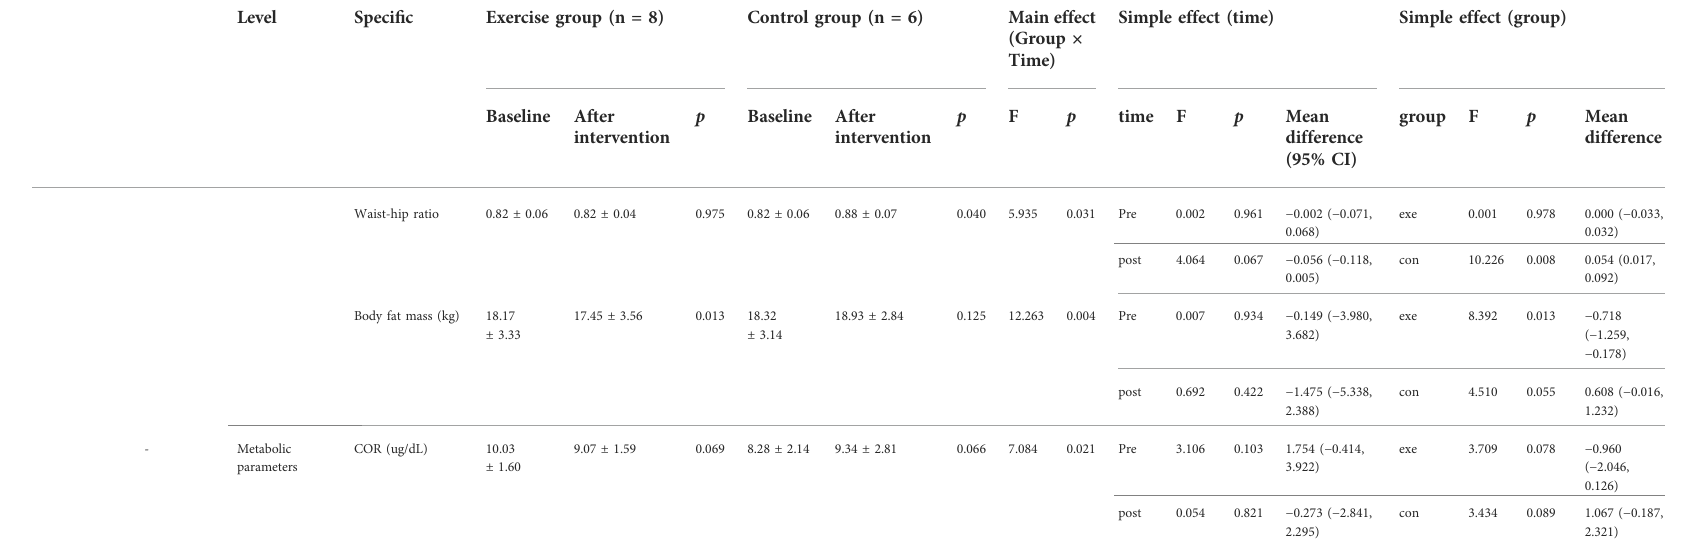
TABLE 2 ( Continued ) Changes in gut microbiota and cardiovascular risk factors in each group following the